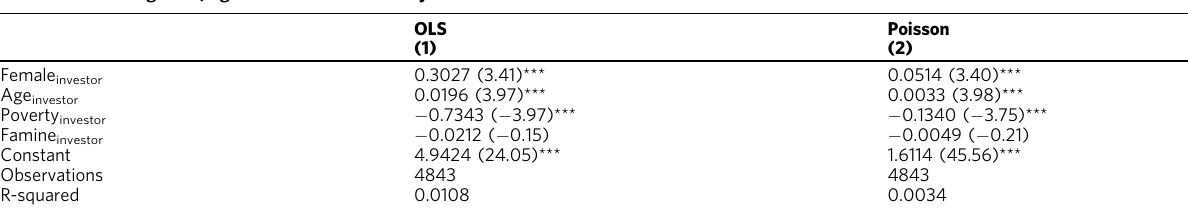
Panel B: referrer-investor relationships and investor hierarchy